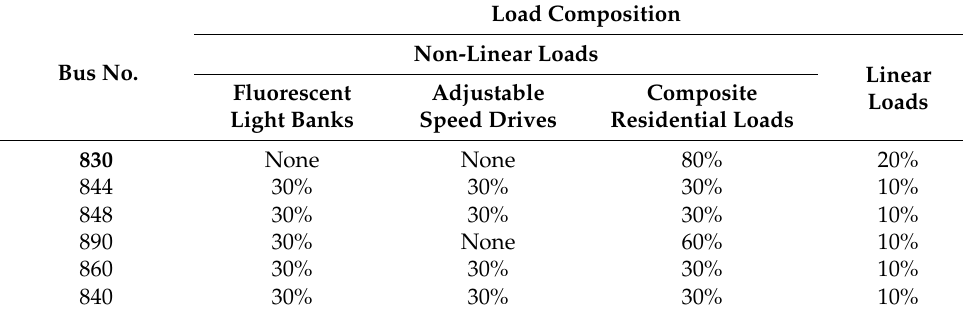
Table 10. Load composition of spot loads in IEEE − 34 bus URDN.